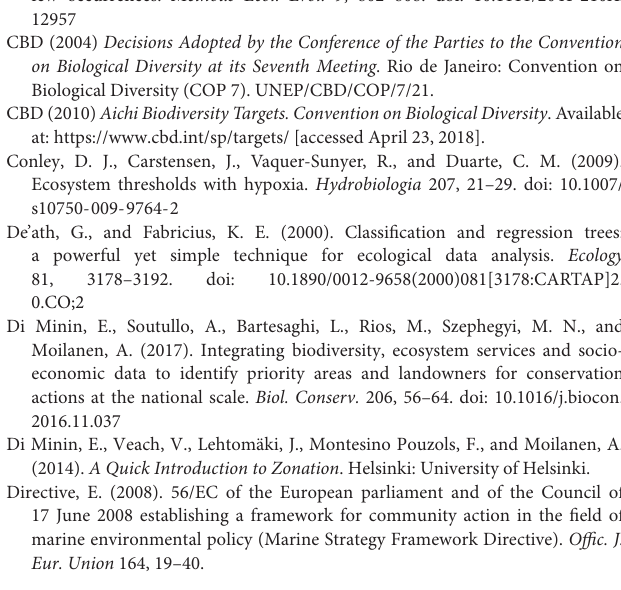
FIGURE S1 | Coverage of distributions of different subgroups under different priority solutions. Red List of Ecosystems and Habitats, based on threatened status (NT, VU), key species and fish reproduction areas. A is the unconstrained solution ( Figure 4A ) and B the current MPA network ( Figure 4B ). TABLE S1 | Species observed in the VELMU programme 2004-2016 from dives and videos, observation thresholds of species included in the model iterations, and a weighting group where each species belongs to (highest weighting criteria reported. If species belongs to another weighting group, the weights have been balanced